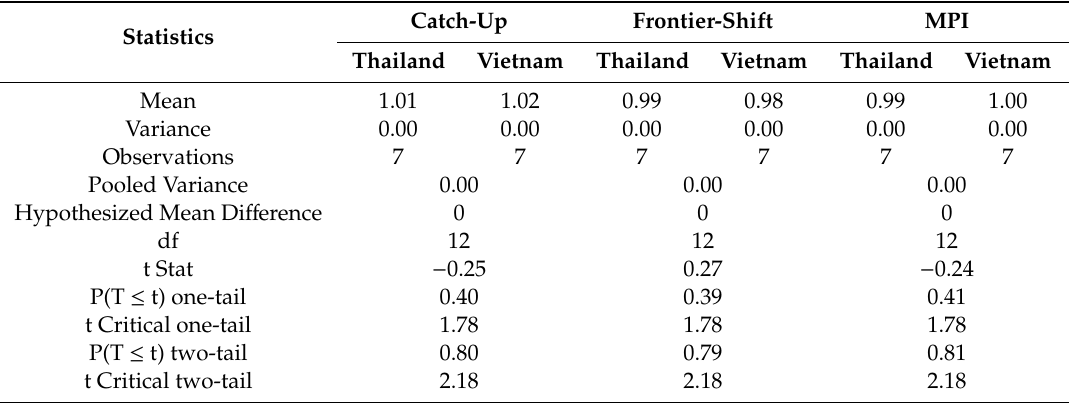
Table 11. Results of t -test of the Malmquist productivity index (MPI) results (two-sample assuming equal